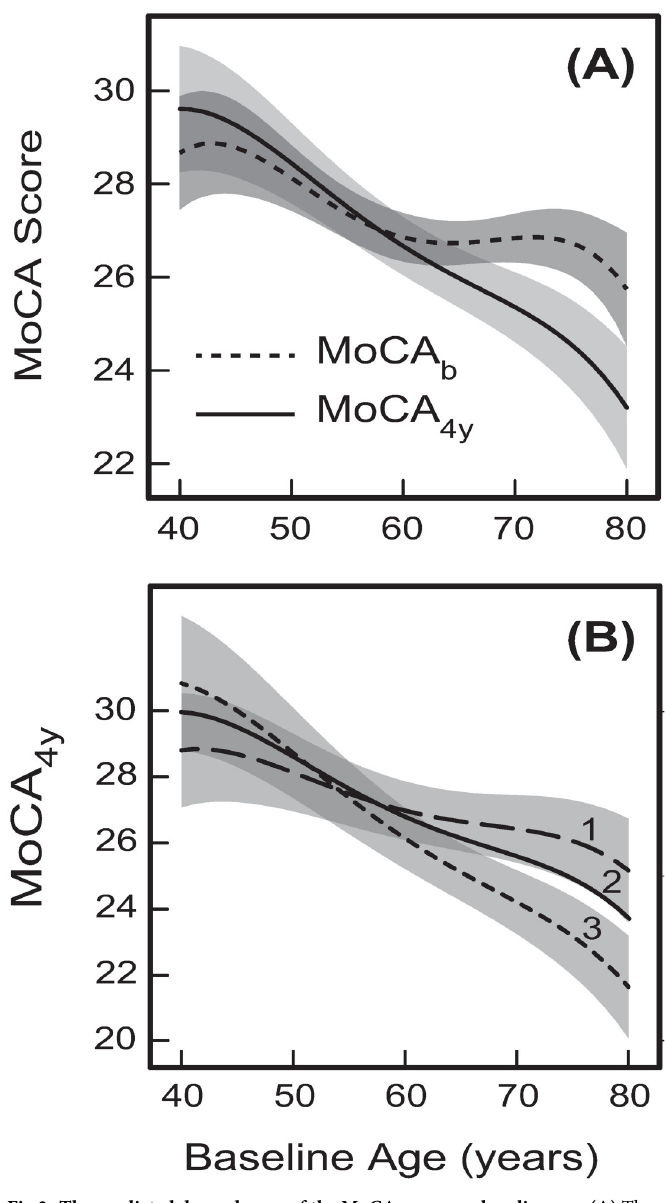
Fig 3. The predicted dependences of the MoCA scores on baseline age. (A) The age dependences for the model with CSF p-tau as the primary predicting protein variable (Fig 1A and 1B); and (B) the age dependences for the model with A β 1–42 as the primary predicting protein variable (Figs 1A and 2). The three curves in (B) are for the three different values of CSF A β 1–42 concentration of 494 pg/ml (0.9 percentile–curve 1), 364 pg/ml (0.5 percentile–curve 2), and 251 pg/ml (0.1 percentile–curve 3). The shaded bands indicate the 95% prediction intervals for the respective dependences. For ease of visual perception, the prediction intervals are not shown for curve 2 in (B) . The other variables were taken at their mean values or base categories: (A) DaT = 1.38, GDS = 2.30, Gender = Male, Education = 15.64 years, and average (p-tau) -1/2 = 0.283 (p-tau = 12.49 pg/ml); (B) DaT = 1.38, GDS = 2.30, Gender = Male, and Education = 15.64 years, or predicted according to the effect paths in the respective GSEM models (Figs 1A, 1B and 2).